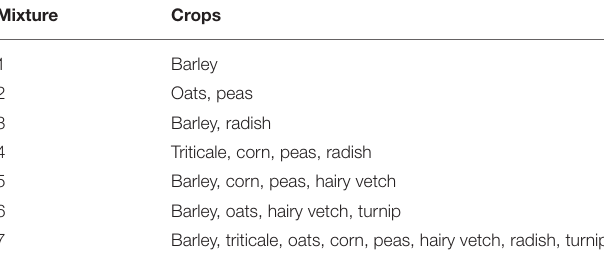
TABLE 1 | List of crop mixtures in the 2015 and 2016 field